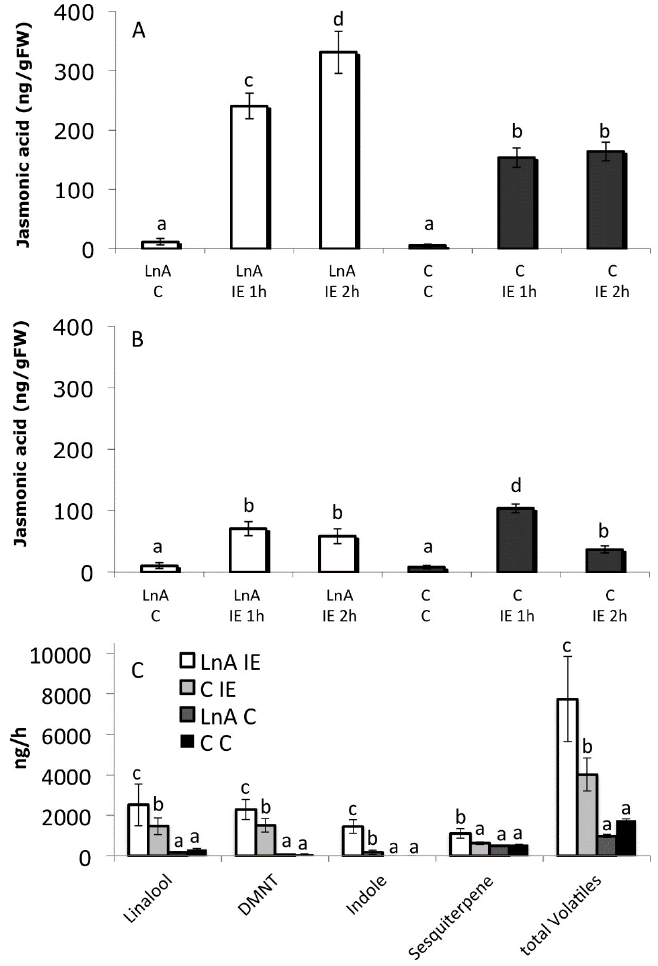
Figure 7. ( A ) Effects of free linolenic acid (LnA) on insect elicitor (IE) induced jasmonic acid accumulation; ( B ) Effects of free linolenic acid (LnA) on mechanical wounding (MW) induced jasmonic acid accumulation; ( C ) Comparison of volatiles release from corn seedlings pre-treated LnA and